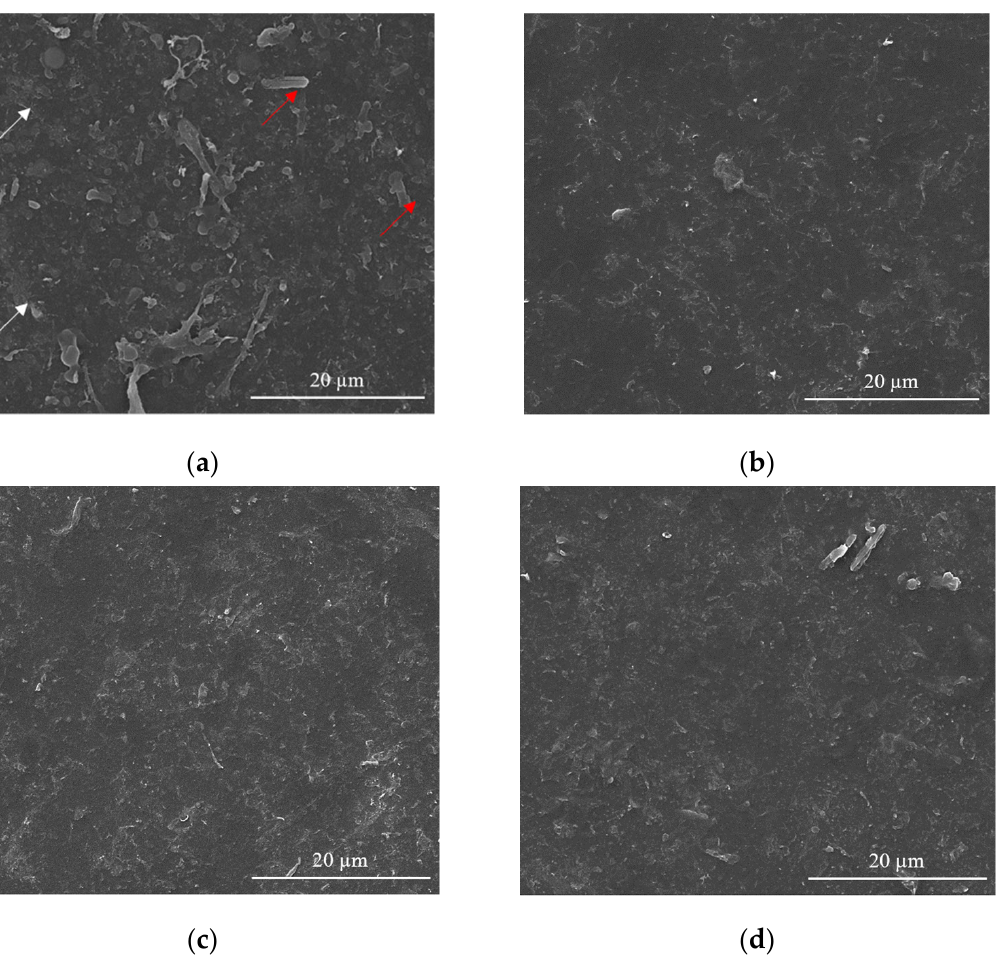
Figure 4. SEM images for of the CNT ‐ Chit ‐ FePc coatings obtained on Si (100) by MAPLE from tar ‐ gets with different compositions: ( a ) (15% CNT + 1% Chit + 1% FePc) in H 2 O (sample A); ( b ) (15% CNT + 1% Chit + 0.4% FePc) in H 2 O (sample B); ( c ) (22% CNT + 1% Chit + 0.4% FePc) in H 2 O (sample C); and ( d ) (22% CNT + 1% Chit + 1% FePc) in H 2 O (sample D).